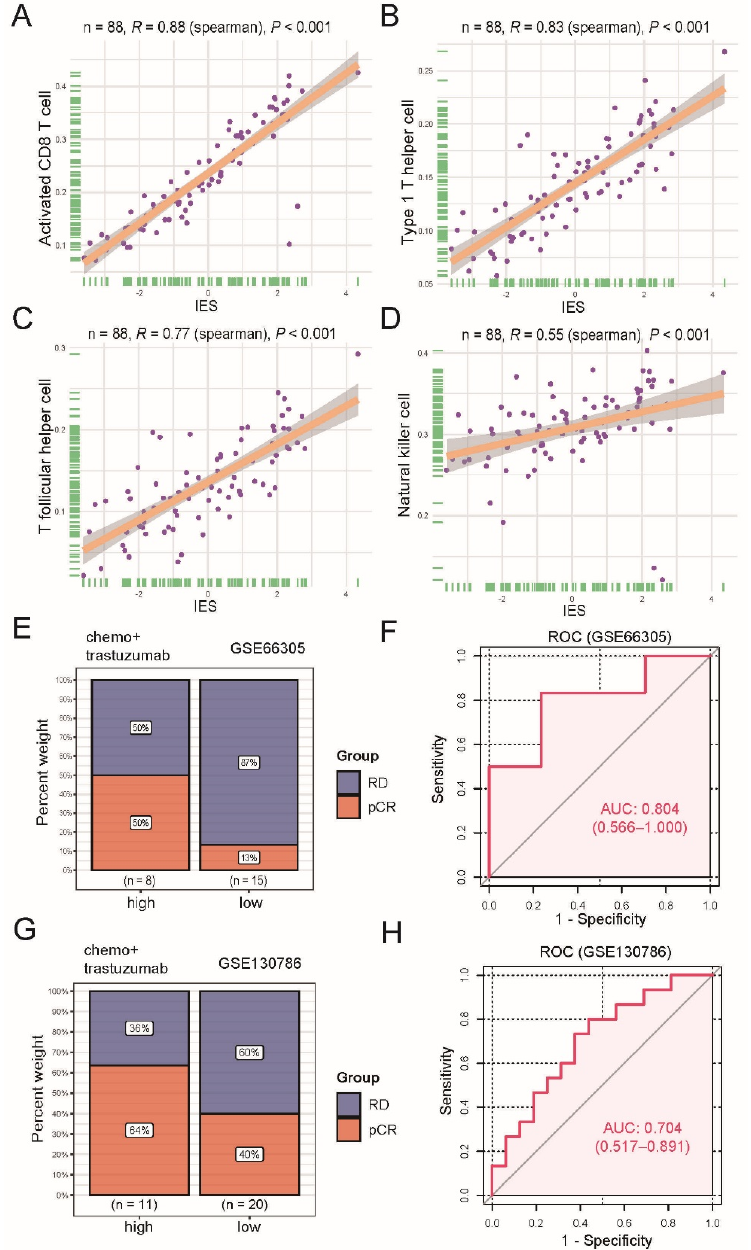
Figure 2. Functional and predictive analysis of immune effective score (IES). Scatter plots display the positive correlation between IES and activated CD8 T cell ( A ), type 1 T helper cell ( B ), T follicular helper cell ( C ), natural killer cell ( D ). The correlation coefficient ( R ) and p values calculated by Spearman’s rank correlation test are given in the figure. The dots represent the data, and the solid line represents the best-fitting curve. The shades around fitted curves indicate 95% confidence interval. Bar plots depict the clinical response rate to neoadjuvant trastuzumab therapy in high or low IES groups in the GSE66305 cohort ( E ) and GSE130786 cohort ( G ). pCR: complete response; RD: residual disease. Receiver operating characteristic (ROC) analysis for predicting pCR to neoadjuvant trastuzumab therapy in the GSE66305 cohort ( F ) and GSE130786 cohort ( H ). Area under the curve (AUC) values are marked and the corresponding 95% confidence interval (CI) is provided in the